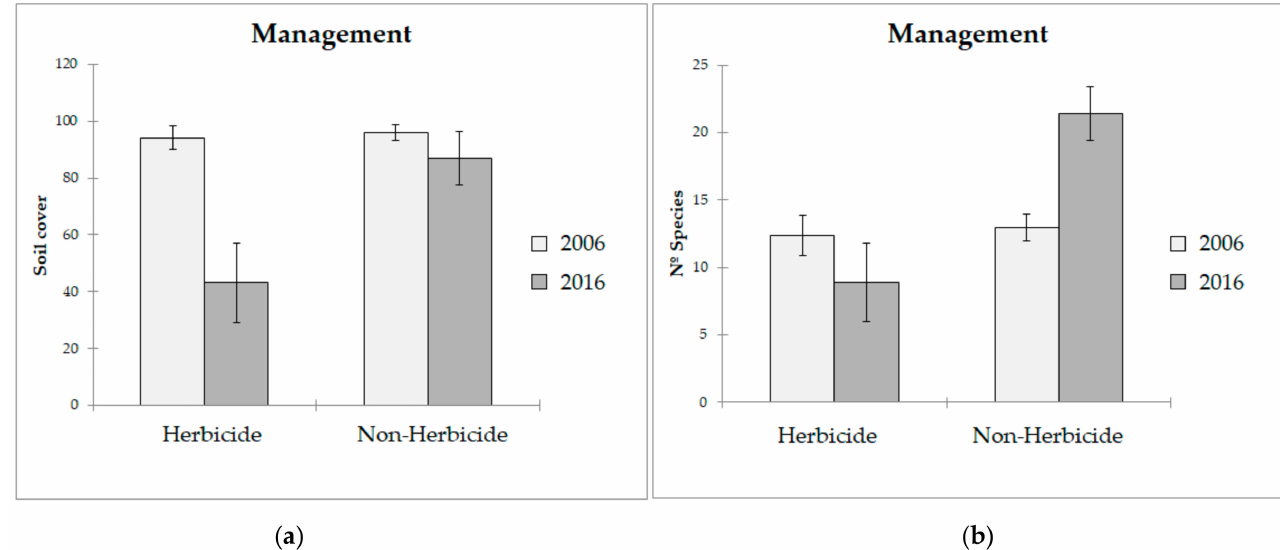
Figure 9. ( a ) Variation in soil cover depending on the grass cover management in the two time periods over 2006–2016. ( b ) Variation in number of species, depending on the grass cover management in the two time periods over 2006–2016. The error bars show the standard